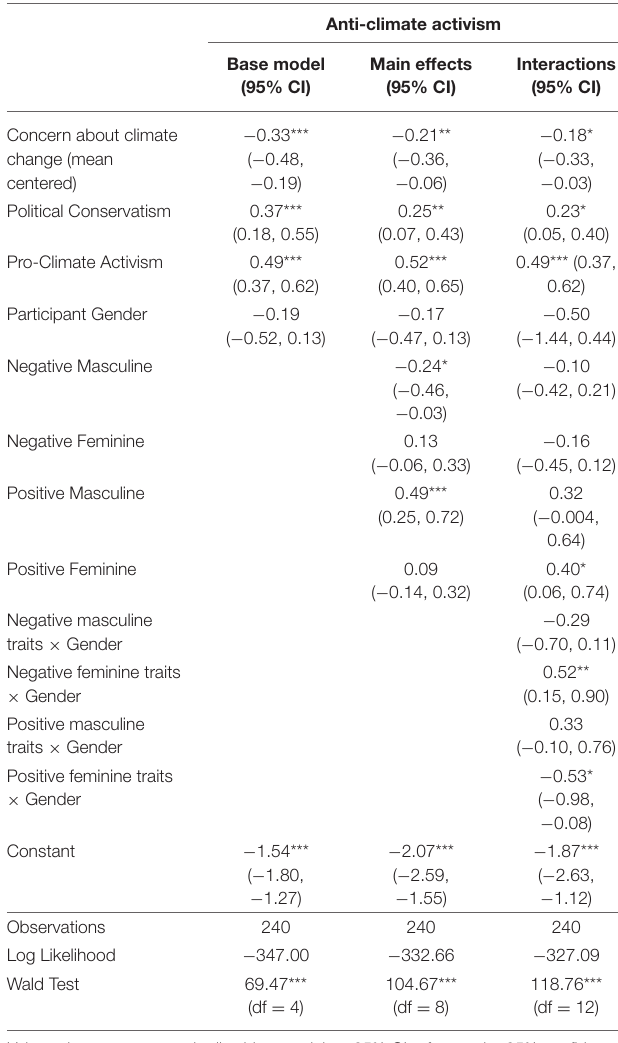
TABLE 5 | Impressions of the climate dismissive as predictors of anti-climate activism (Study